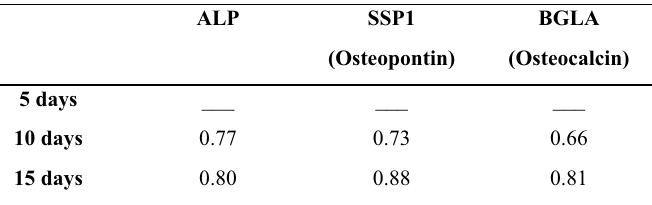
TABLE 2 - Normalized CT values of the ALP, SSP1, and BGLA genes’